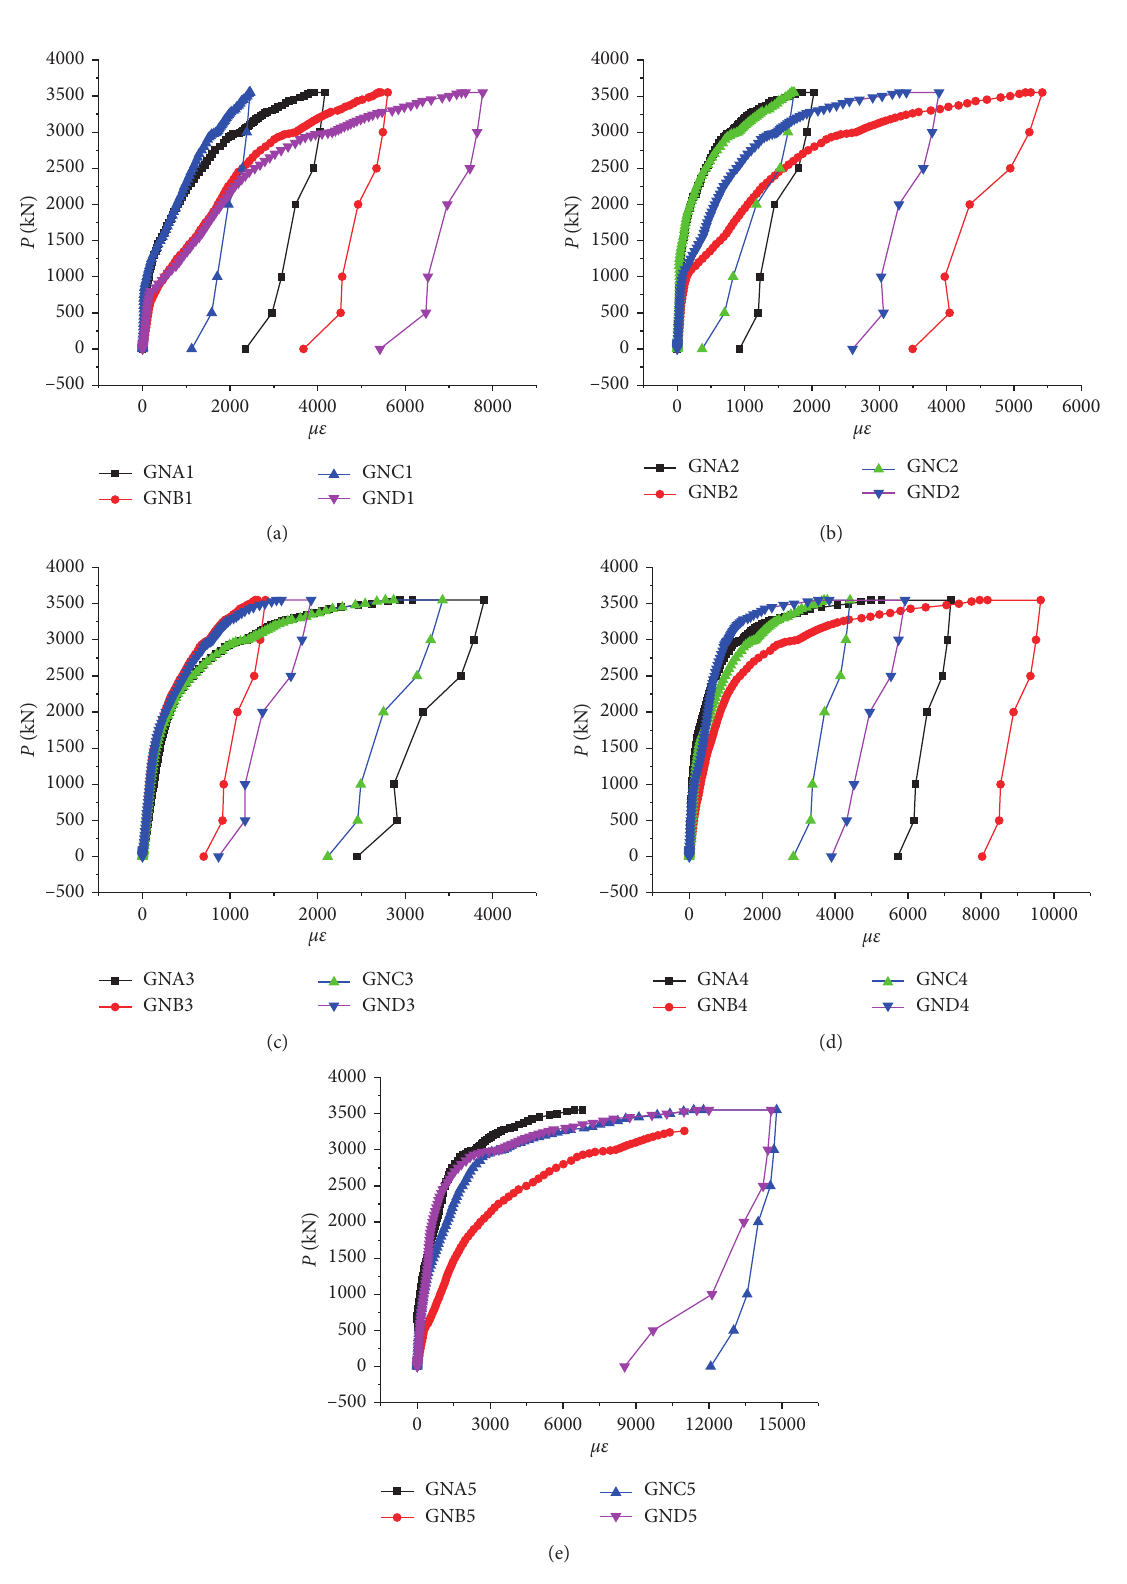
Figure 6: Load-strain curves of binding